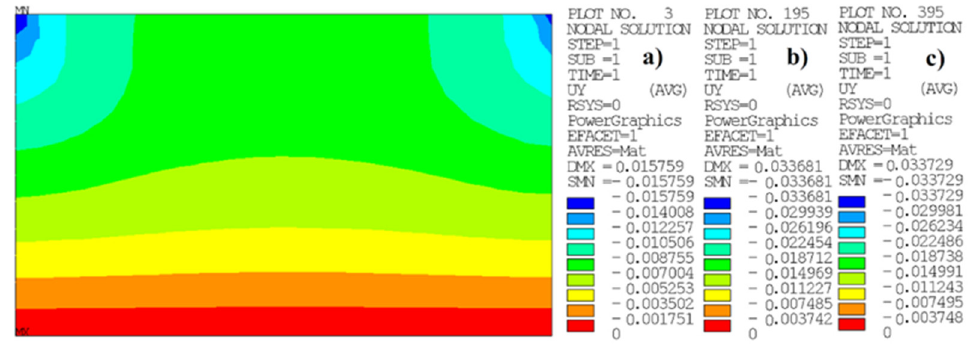
Figure 4. U y displacement below the foundation at ( a ) 13.93, ( b ) 682.57, and ( c ) 1379.07